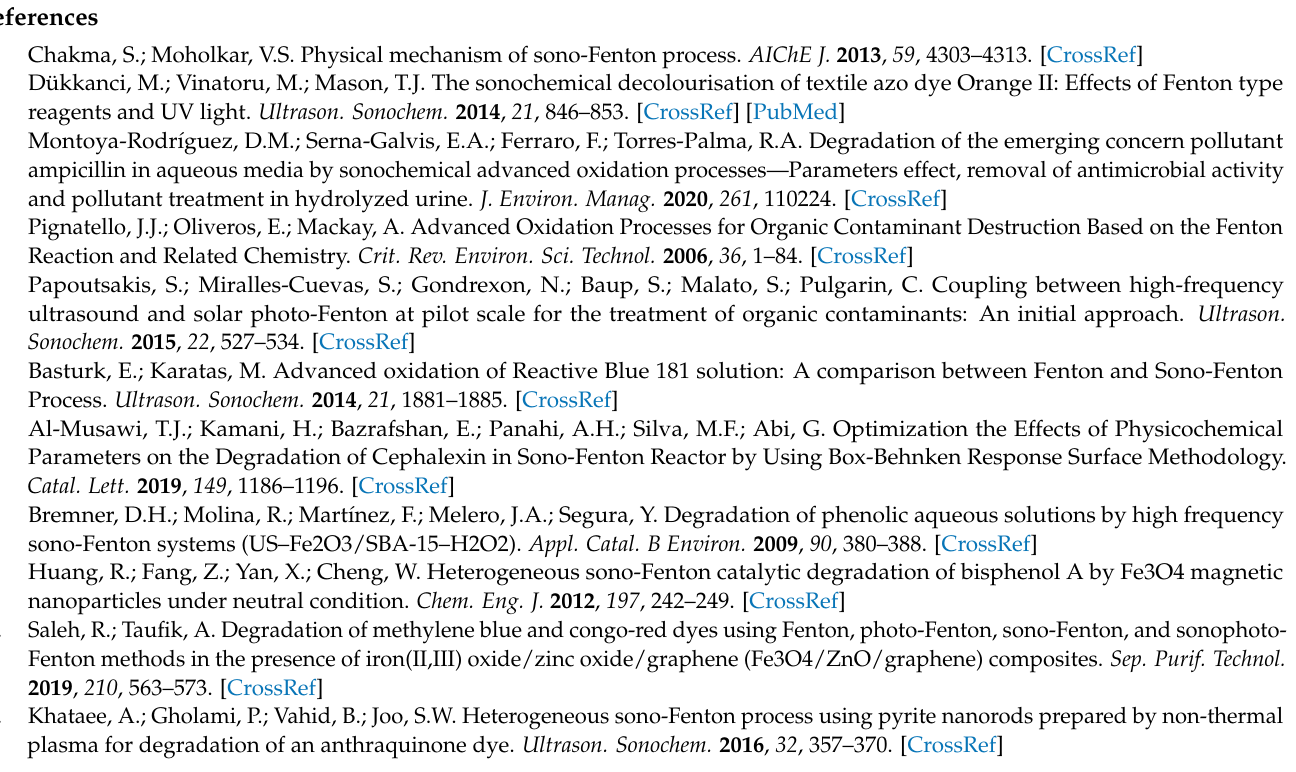
mineral; Figure S2: (a) Adsorption of ACE on the natural mineral, (b) XRD pattern of the Colom- bian natural mineral, Figure S3: UV-Visible spectrum of CIP and its interaction with ferrous ions; Figure S4: UV-Visible spectrum of ACE and its mixture with ferric and ferrous ions; Figure S5: Mass spectrum of CIP; Figure S6: Mass spectrum of Product 1; Figure S7: Mass spectrum of Product 2; Figure S8: Mass spectrum of Product 3. Figure S9: pseudo-first-order rate constant (k) deter- mination example, Table S1: Values of pseudo-first-order constants (k) for the degradation of the target